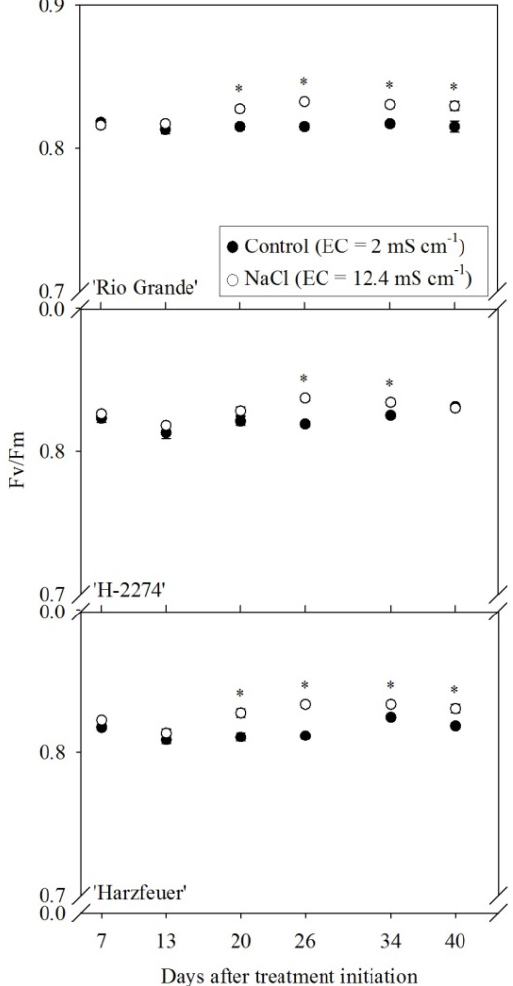
Figure 1. Maximal photochemical efficiency (Fv/Fm) of tomato leaves. Measurements were taken from “Rio Grande”, “H-2274” and “Harzfeuer” in the course of the experiment. * Significant differences according to t -test ( p ≤ 0.05; n = 10) between control and NaCl treatment for each genotype and measuring day; all data were expressed as the mean ±